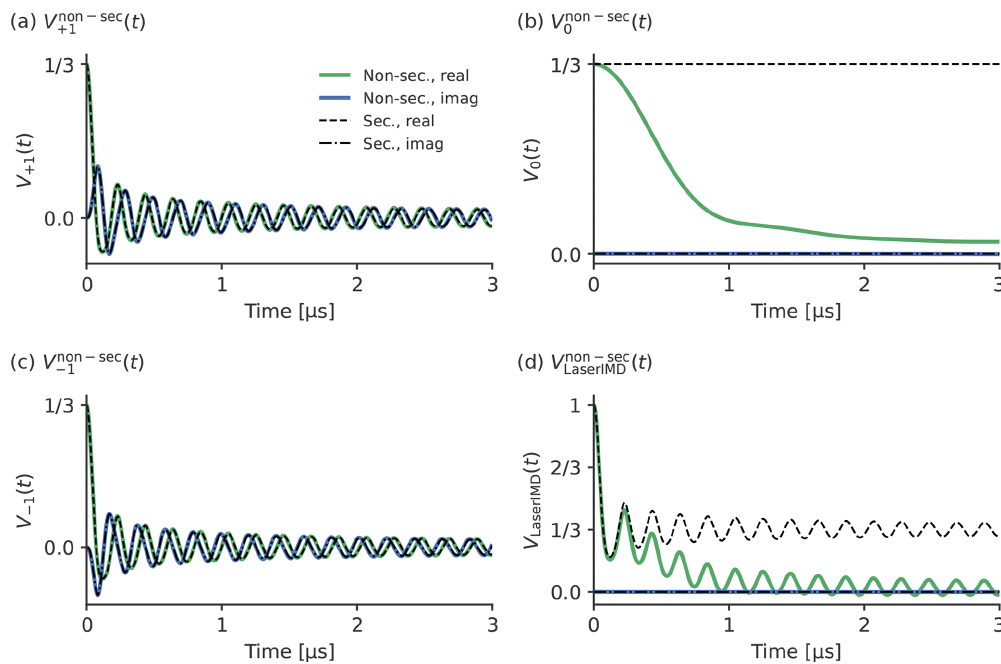
Figure 4. Comparison of simulated LaserIMD traces with and without non-secular interactions with the values D = 1159 and E = − 238MHz; P x = 0 . 33, P y = 0 . 41 and P z = 0 . 26; ν T = 9 . 3GHz (X-band); and r = 2 . 2nm for (a) V non-sec +